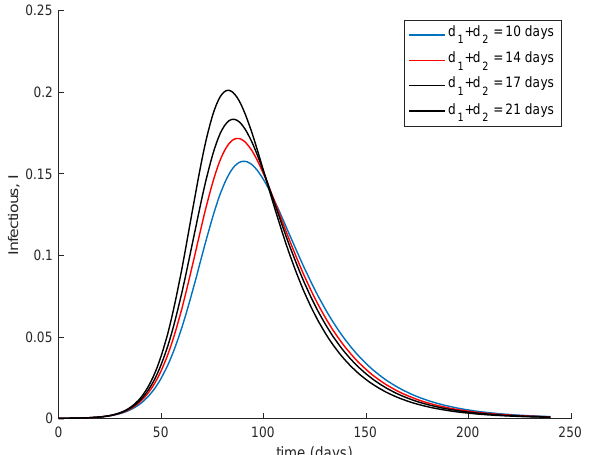
Figure 7. Dynamics of the infectious for different time periods between the two doses.